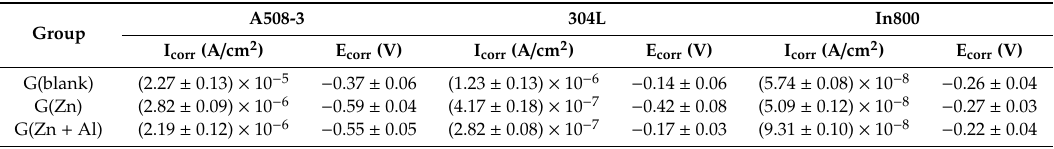
Figure 1. The polarization curves in semilogarithmic coordinates of the passive films formed on ( a ) A508-3, ( b ) 304L and ( c ) In800 with different treatment method. Table 3. The corrosion current (I corr ) and corrosion potential (E corr ) of the passive films formed on A508-3, 304L and In800 with di ff erent treatment